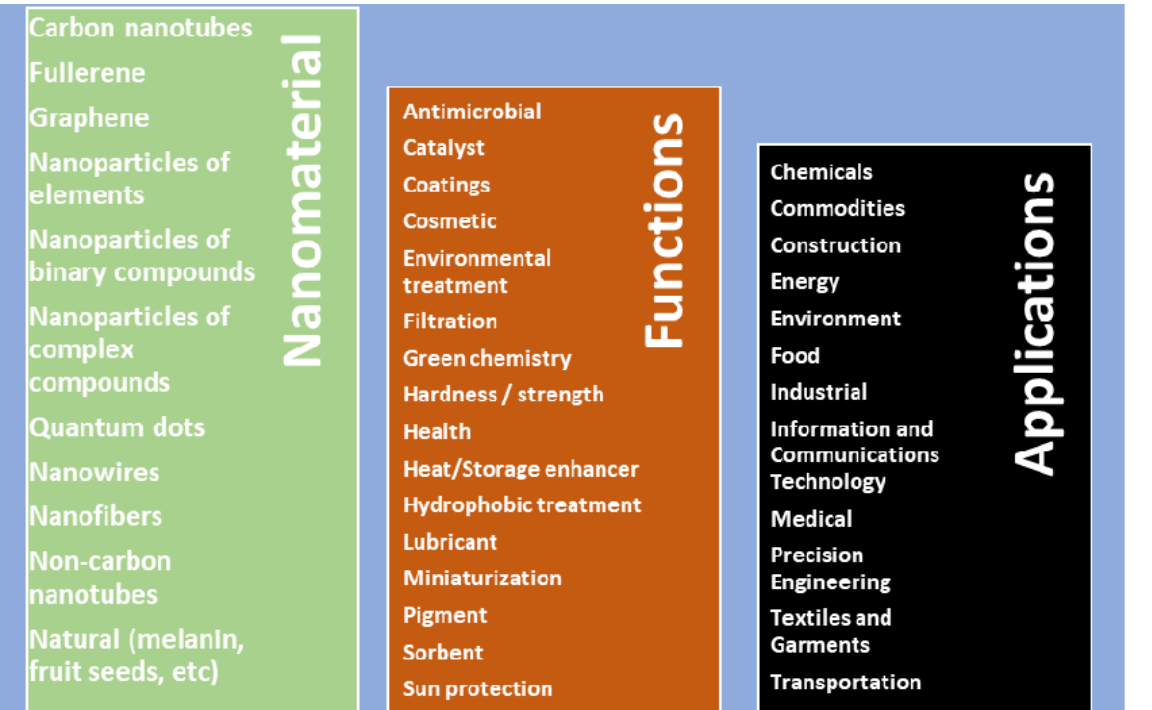
Figure 1. Nanomaterials, their functions and applications.